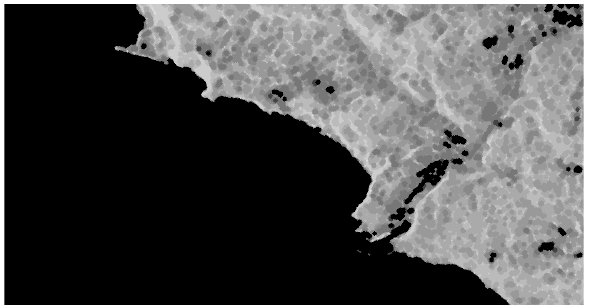
Figure 7. Mathematical morphology closing applied image